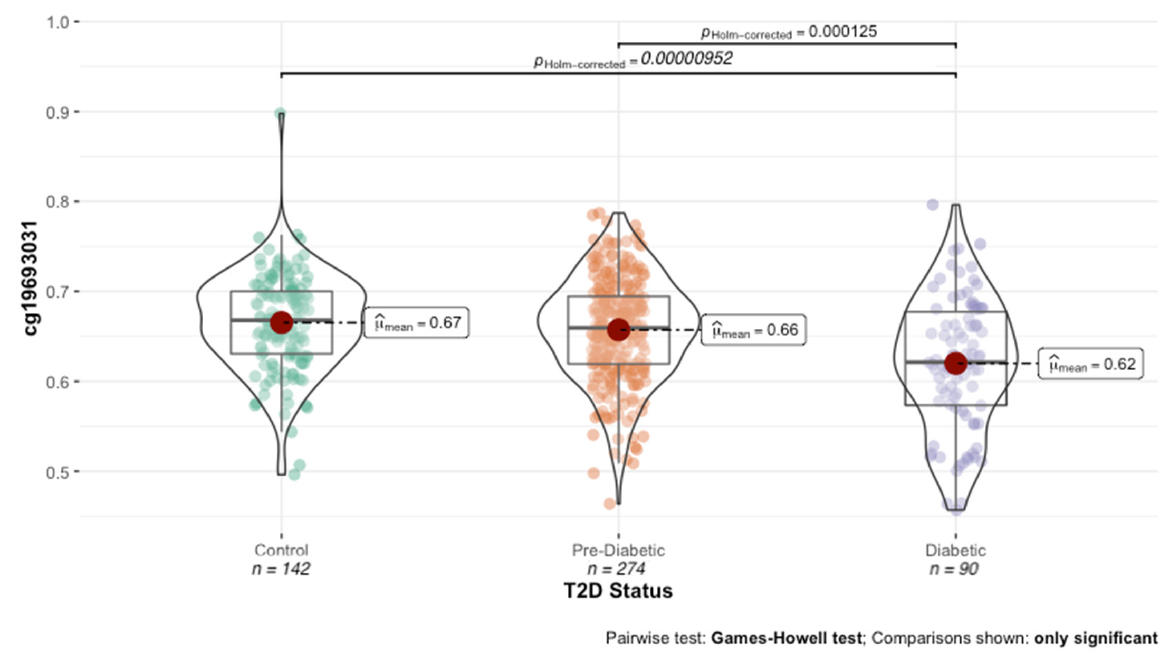
Figure 1. Distribution of cg19693031 methylation across T2D status.